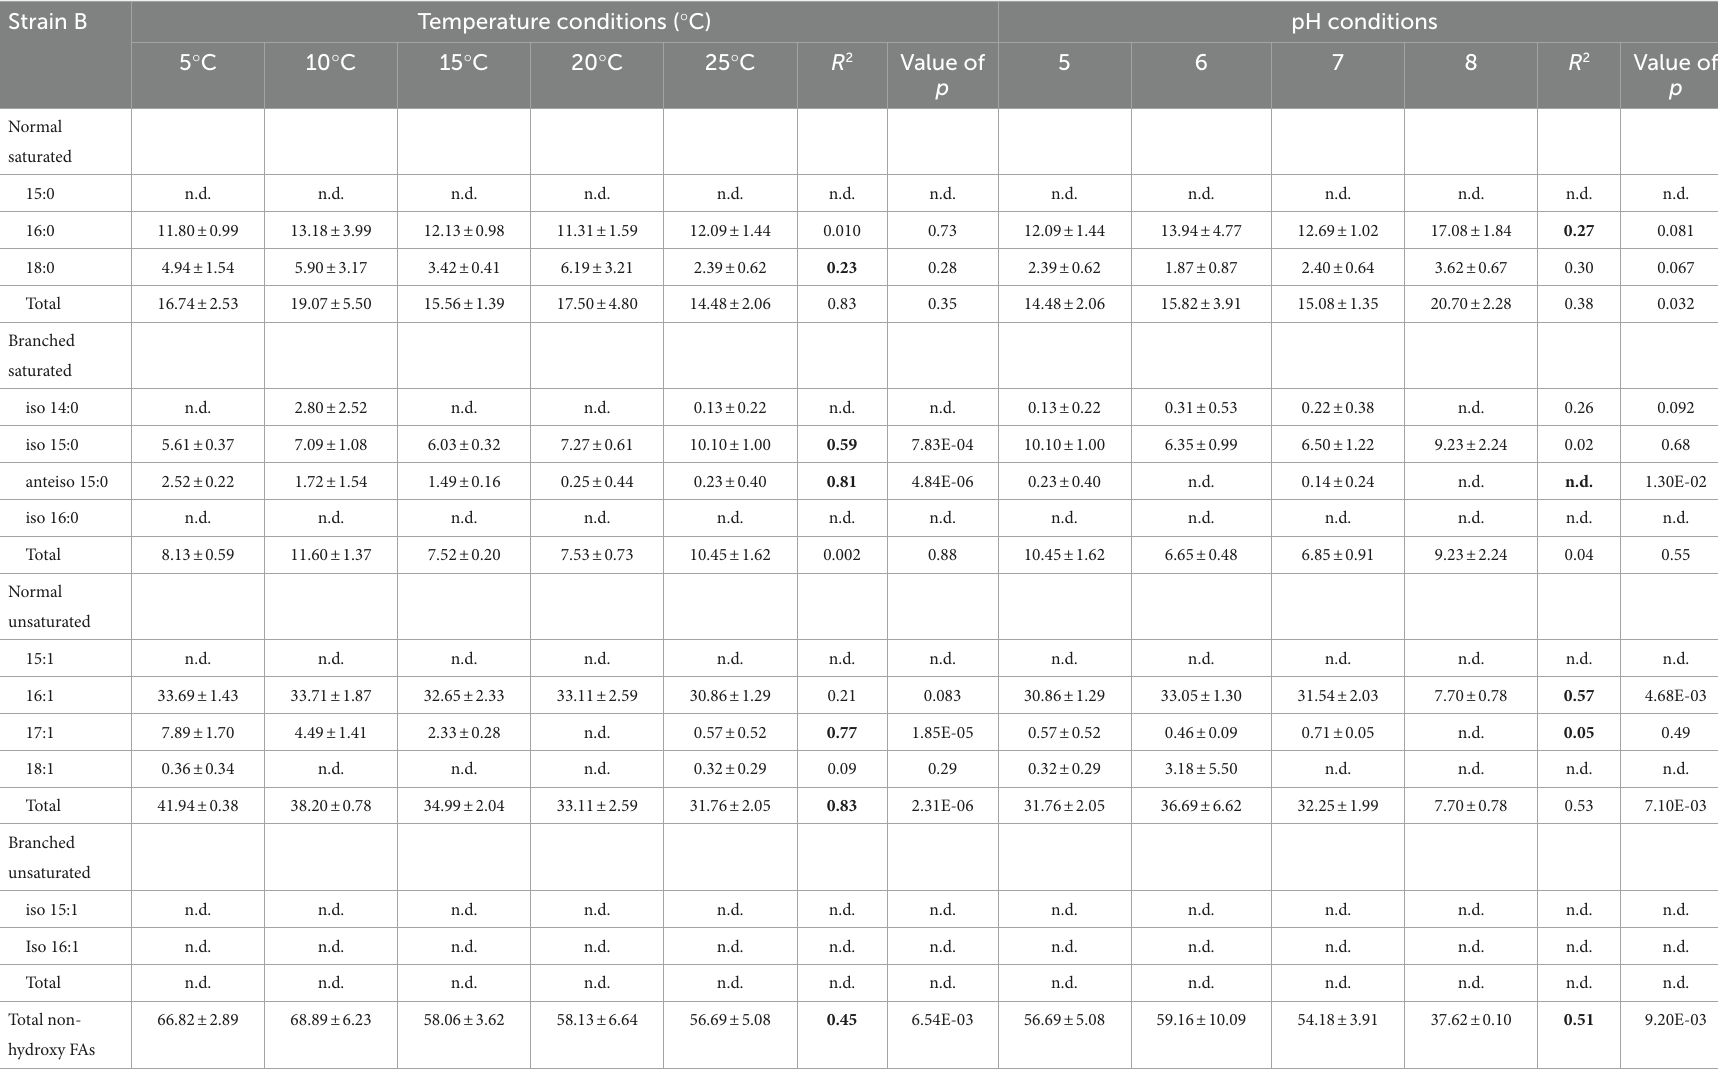
TABLE 2 Relative percentage abundances of non-hydroxy fatty acids vs. total fatty acids for strain B under different temperature conditions (at pH 5) and at different pH conditions (at 25 ° C). Strain B